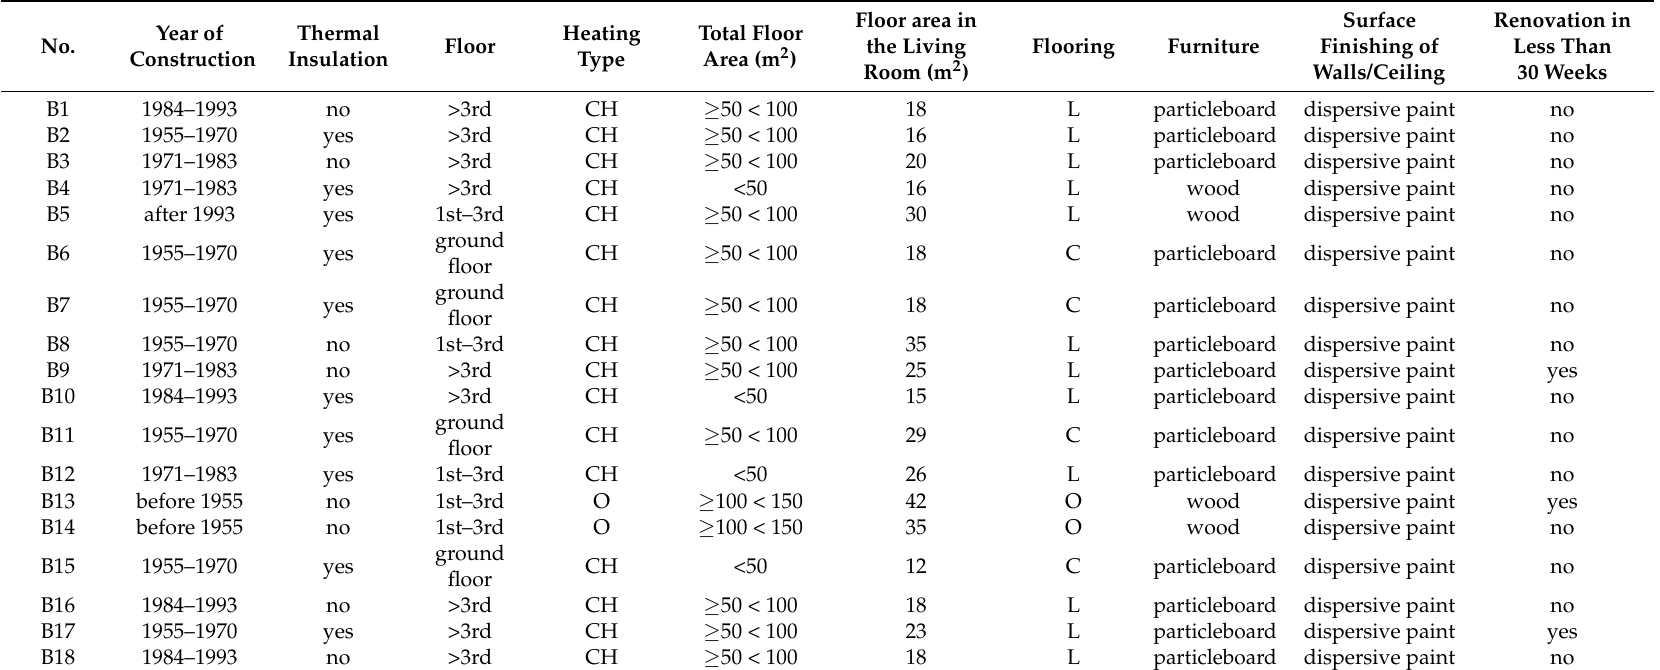
Table A1. Basic information about the apartments—Part